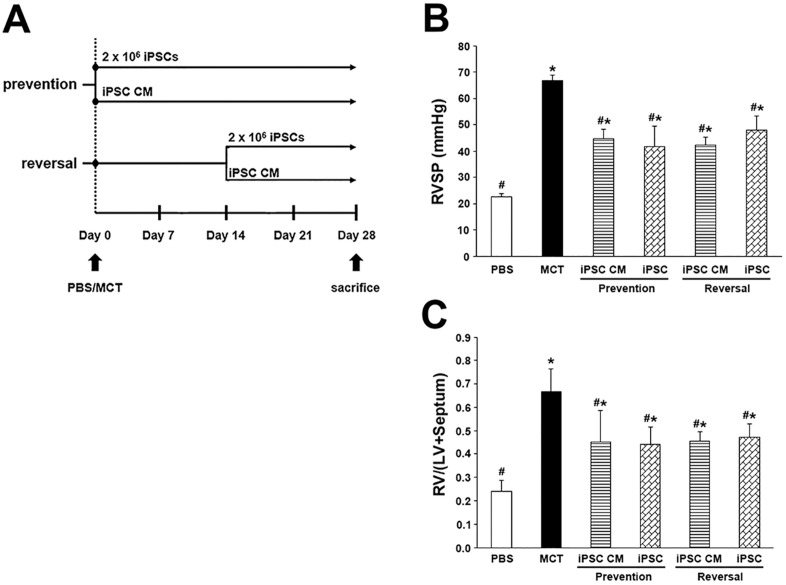
Effect of iPSC-based therapy on RVSP and the weight ratio of RV/(LV+Septum).Representative scheme of iPSC-based therapy on MCT-induced PAH. (B) Hemodynamic changes in RVSP were analyzed across animal groups at day 28 prior to sacrifice. (C) RV hypertrophy was measured by comparing the weight ratio of RV/(LV+Septum) of different groups. The results are shown as the mean ± SD for 6 rats of each group. *p<0.05 vs. PBS group; #p<0.05 vs. MCT group.